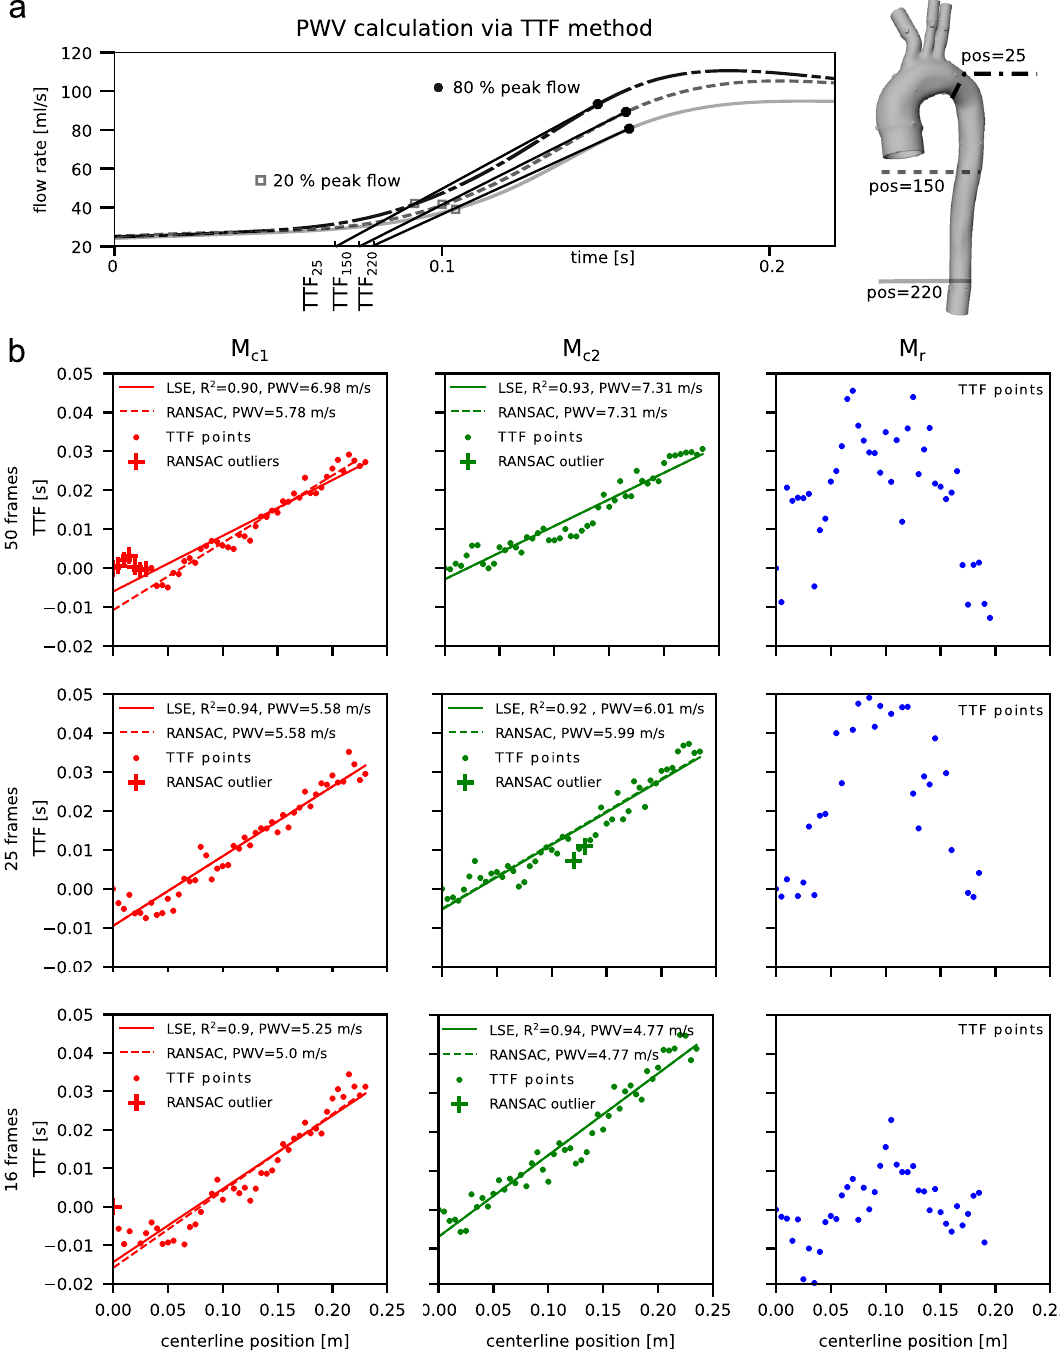
Figure 7. ( a ) Principle of retrieving TTF values at three positions along the descending aorta centerline. ( b ) PWV calculations for models M c1 (red), M c2 (green), and M r (blue) for three temporal sampling rates (row 1 through 3). Scattered points depict TTF of flow rate waveforms extracted at equidistantly spaced cross sections along c DAo (Fig. 1f). All TTF values are shown as TTF differences to TTF at centerline position 0. Conventional 2 LSE linear regression (solid line, with R given in legend) and RANSAC (dashed line with assigned outlier marked +) were used to derive PWV values, defined as the inverse slope of the respective line (given in legend). Differences in PWV were observed between models M c1 and M c2 . However, temporal sampling rates impacted these values, with decreasing PWV estimates for lower temporal resolution. It appears that PWV in model M r is too fast such that plausible TTF along the centerline cannot be resolved with the 4D-flow based approach. LSE is very sensitive to outlier data which was apparent in data M c1 (50 frames) and M c1 (16 frames). For the latter one, four TTF points laid outside the displayed y-axis with linear regression deviations >100 × RMSE and were thus excluded prior to fitting the model. TTF, time-to-foot; LSE, least-squared-error; RANSAC, random sampling consensus; RMSE, root-mean-squared-error. Plots created using Python (v3.6, https:// www. python.